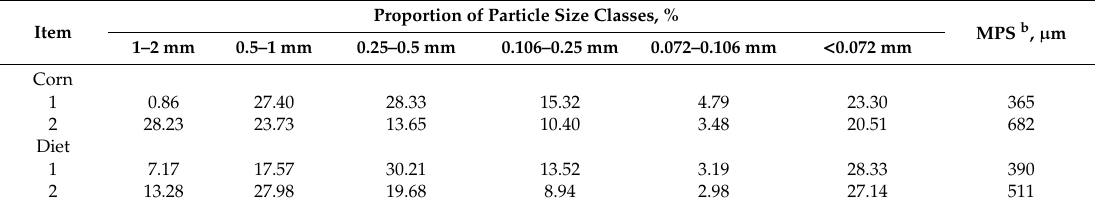
Table 2. The particle size classes and MPS of corn and diets a .